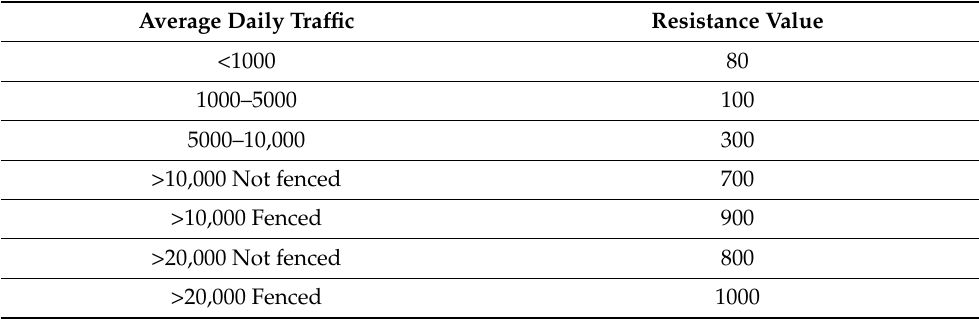
Table A2. Resistance values for average daily traffic of infrastructures of the study area.